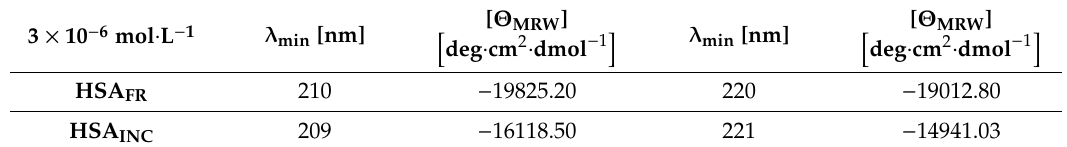
Table 4. [ Θ MRW ] at λ min for 3 × 10 − 6 mol · L − 1 HSA FR and HSA INC